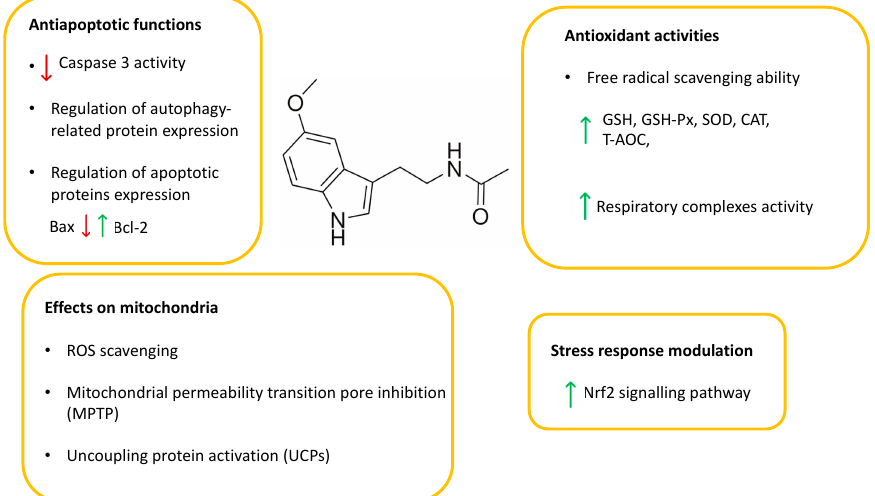
Figure 3. Melatonin cytoprotection function. Melatonin protects the cell from oxidative stress by inducing the expression of antioxidant genes (up arrow) such as glutathione peroxidase (GSH-Px), superoxide dismutase (SOD), catalase (CAT) and by increasing the total antioxidant capacity (T-AOC) in the presence of a stimulation of respiratory complexes activity. These effects are mediated by the stimulation of transcriptional proteins, such as nuclear factor erythroid 2 (Nrf2), the activity of which is particularly important for the CPA and stress adaptation effects of melatonin. Melatonin exerts antiapoptotic effects by decreasing (down arrow) Caspase 3 and Bax activity and by increasing (up arrow) the expression of B-cell lymphoma protein 2, e.g., Bcl-2. Other effects include the modulation of autophagy-related proteins. Moreover, melatonin acts directly on mitochondria, acting as an ROS scavenger, inhibiting the activity of MPTPs proteins, and activating UCP proteins. Upward and downward arrows correspond to “increased” and “decreased” expression or function of the reported parameters, respectively.